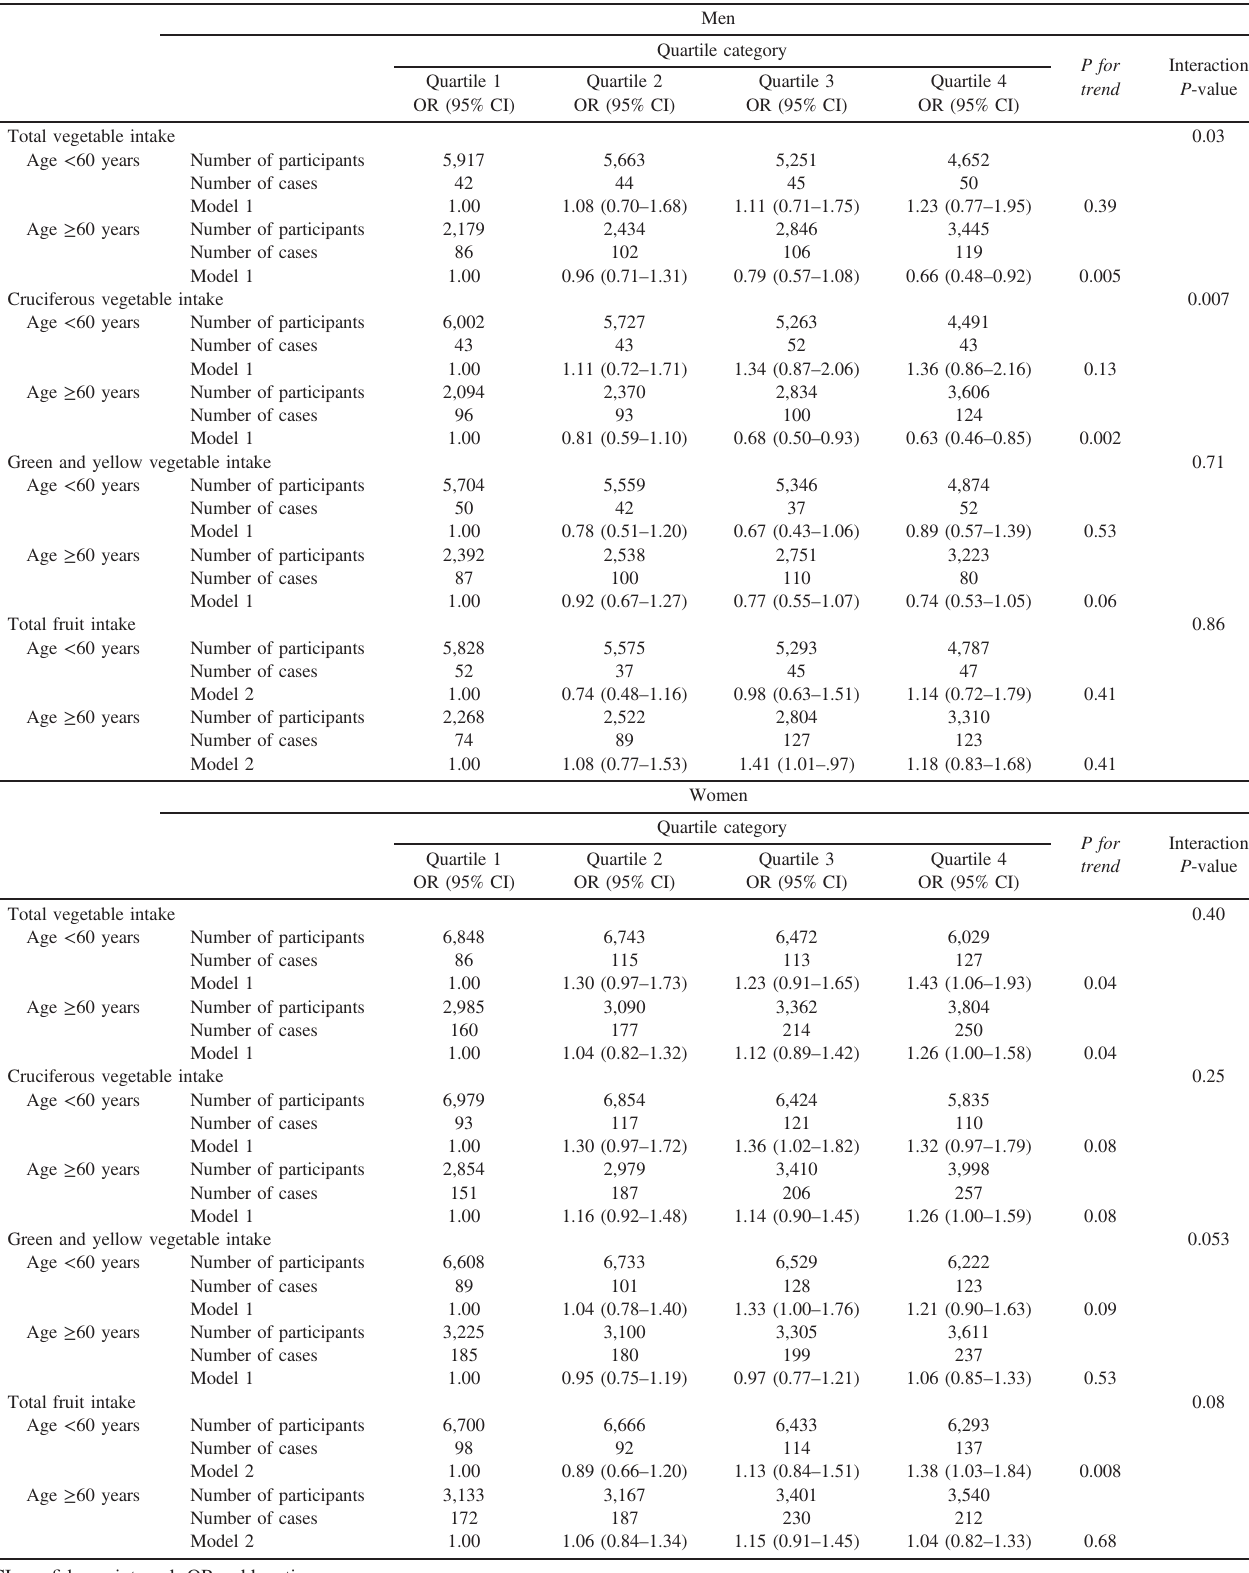
Table 4. Multivariate odds ratios for cataract incidence according to total vegetable, cruciferous vegetable, green and yellow vegetable, and fruit intake category in men and women strati fi ed by